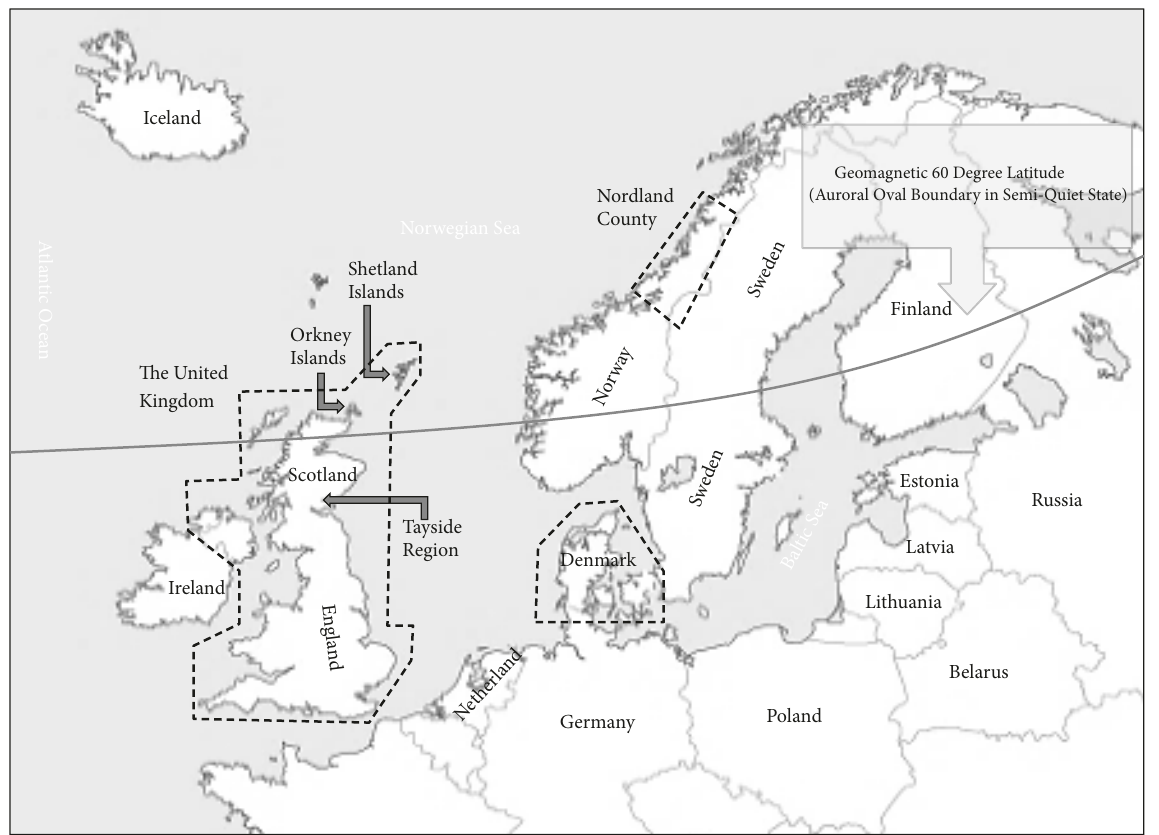
Figure 1: Geographical location of the studied regions and their distance from